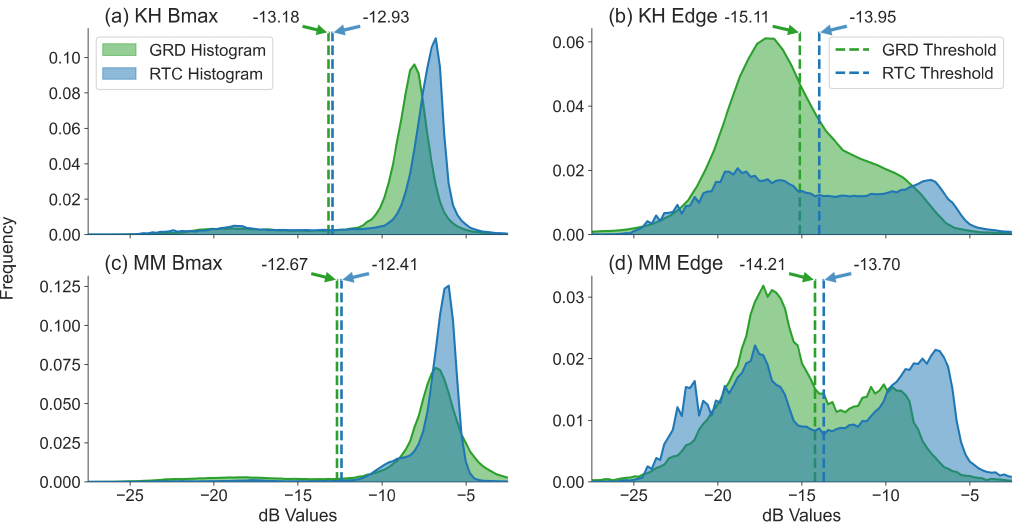
Figure 7. Histograms highlighting the values sampled from the GRD (green) and RTC (blue) data using the Bmax Otsu (left) and Edge Otsu (right) algorithms for the Cambodia (KH; left) and Myanmar (MM; right). Note the different scales on the y-axis due to the different number of pixels sampled depending on the